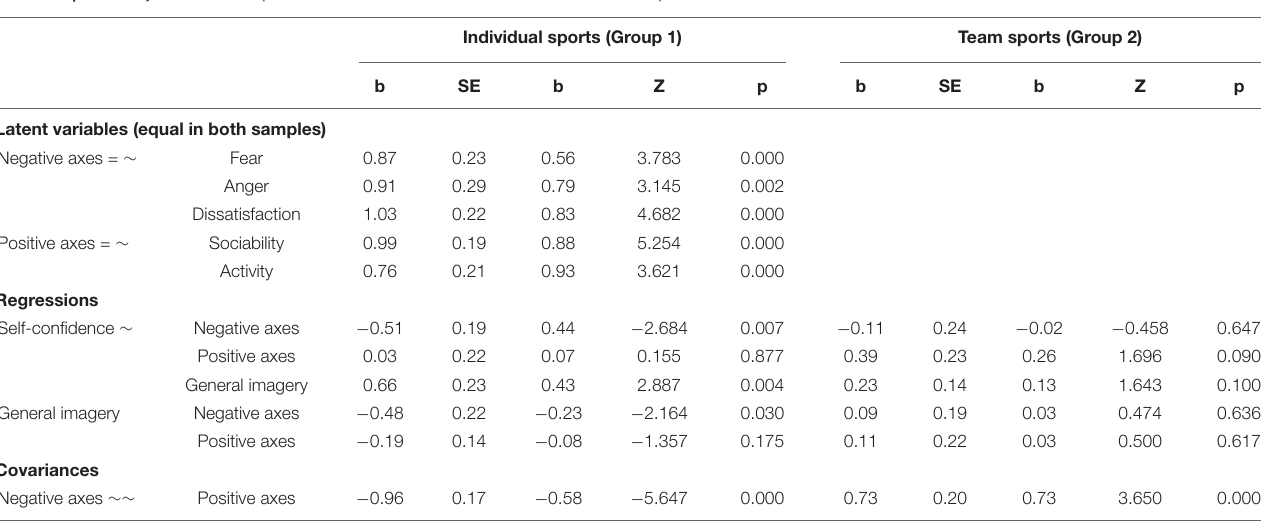
FIGURE 2 | Result diagram of SEM model estimated in athletes training individual ( N 1 = 73) and team ( N 2 = 68) sports. Individual sports are coded as Group 1 and Team sports are coded as Group 2. * p < 0.05, ** p < 0.01, *** p < 0.001. TABLE 5 | Summary of model comparison for tested models in individual and team